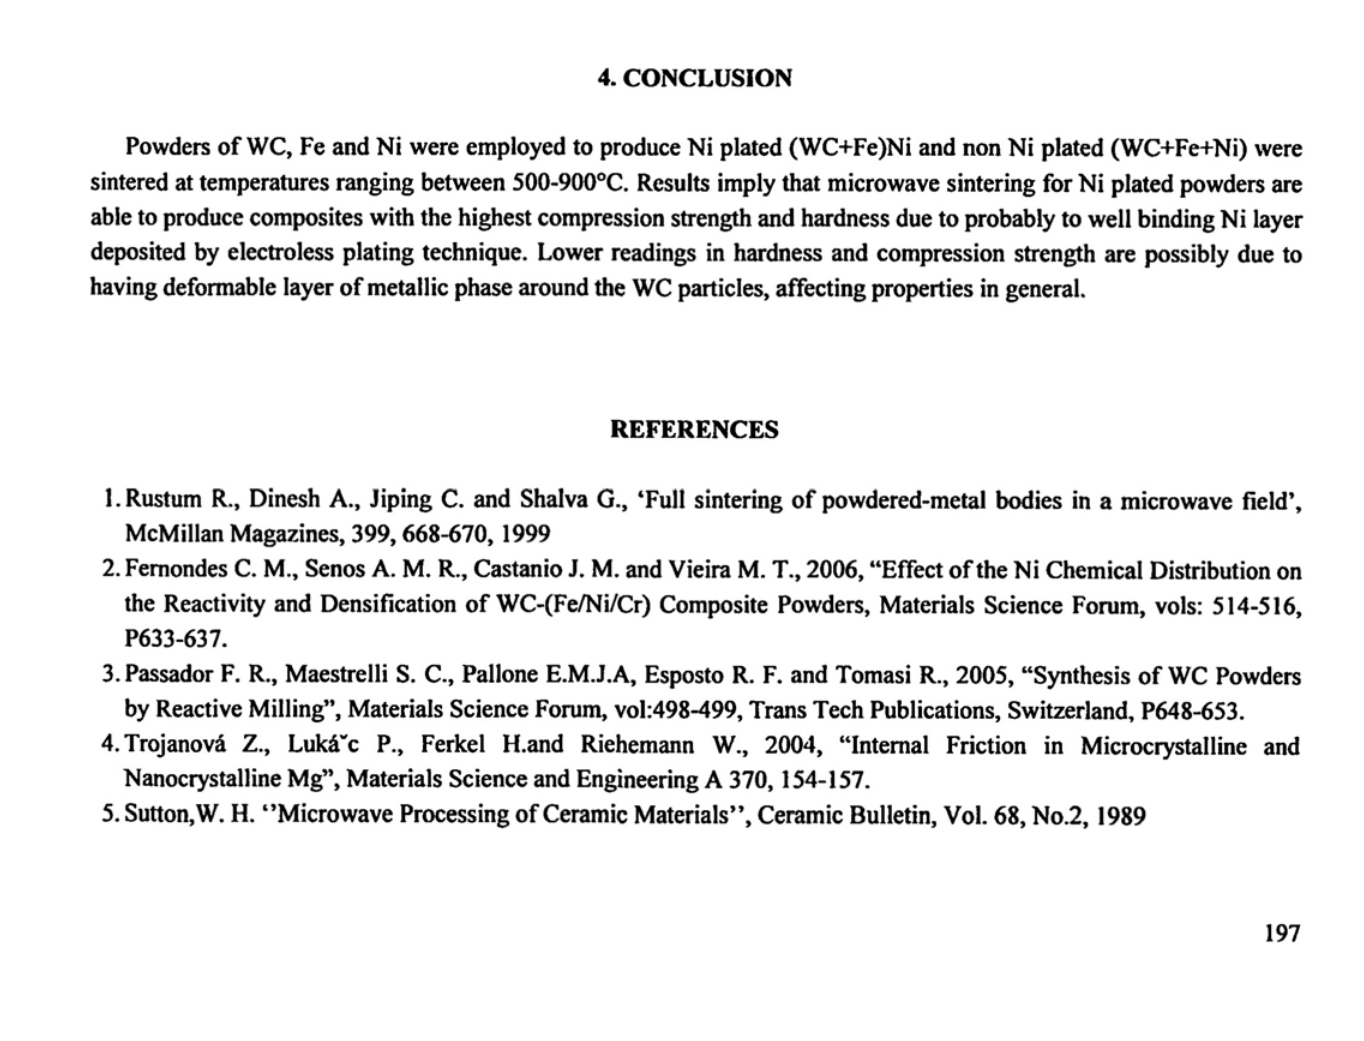
Fig. 8: XRD analysis results from sintered specimens a) (WC+Fe)Ni and b)